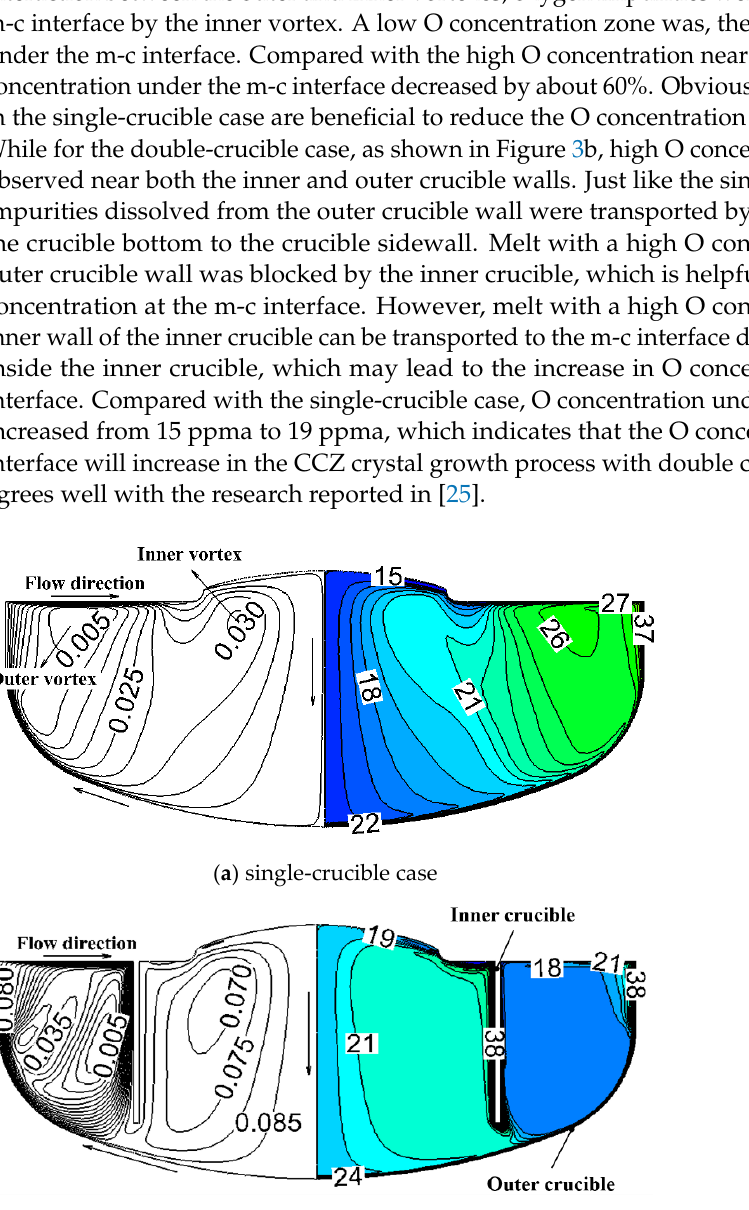
a m p p Figure 4. The oxygen distribution (ppma) at crucible walls. 3.2. Study of the O Source at the Melt-Crystal Interface with Double-Crucible Method To make clear which crucible is the dominant source of oxygen impurities trans- ported to the m-c interface in the double-crucible CCZ method, we investigated the impact of the inner crucible and the outer crucible, respectively, on the O concentration at the m- c interface. For the sake of convenience in our numerical investigation, we introduced a concept of a virtual coating layer that is of no thickness and no oxygen dissolution. For example, when the inner crucible walls are covered with the virtual coating layer, there is no oxygen dissolved into the melt from the inner crucible. Therefore, the outer crucible becomes the unique source of oxygen impurities. In Figure 5a, we show the O distribution in the melt for the case in which the outer crucible was covered by this virtual coating layer, which means that the inner crucible was the unique source of oxygen impurities in the melt. Compared with the results in Figure 3b, we found that the O concentration under the m-c interface only slightly de- creased. Correspondingly, in Figure 5b, we show the O distribution in the melt for the case in which the inner crucible was covered by this virtual coating layer, which means that the outer crucible was the unique source of oxygen impurities in the melt. It is obvi- ously found in this case that the O concentration under the m-c interface was remarkably reduced as compared to the results shown in Figures 3b and 5a. In Figure 6, we compared the impact of the inner crucible and outer crucible on the oxygen distribution at the m-c Height / m c O /